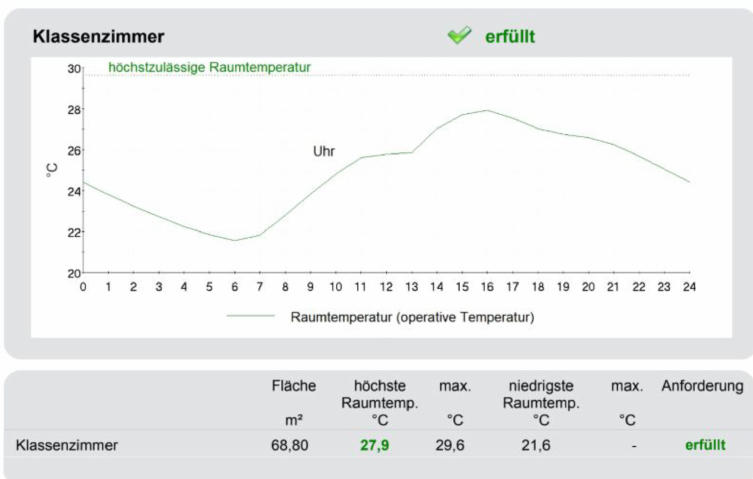
Figure 8. Calculation of summer